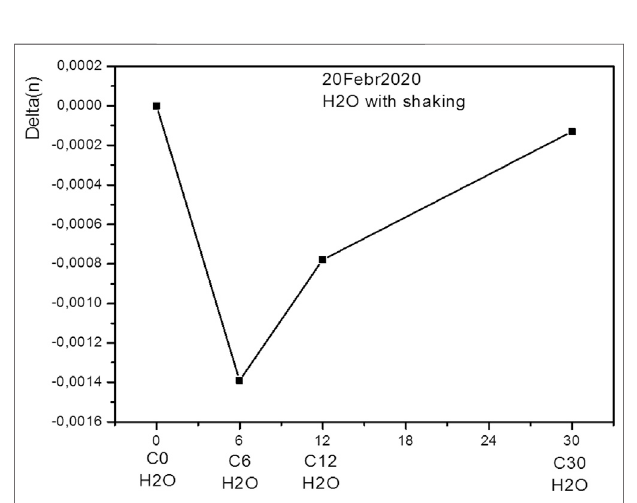
FIGURE 6 | Relative refractive index of the deionized water subjected to shaking for different number of dilutions.